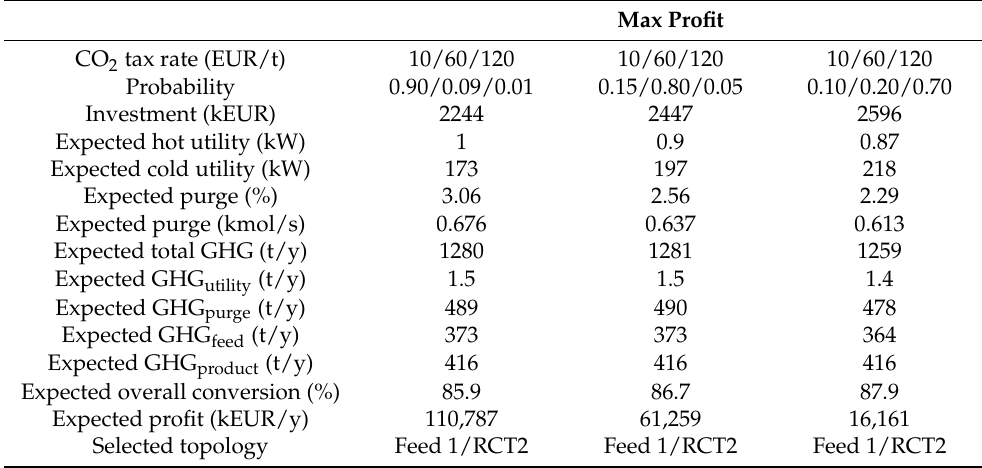
Table 3. Results of the one-period process synthesis at different values of CO 2 tax.